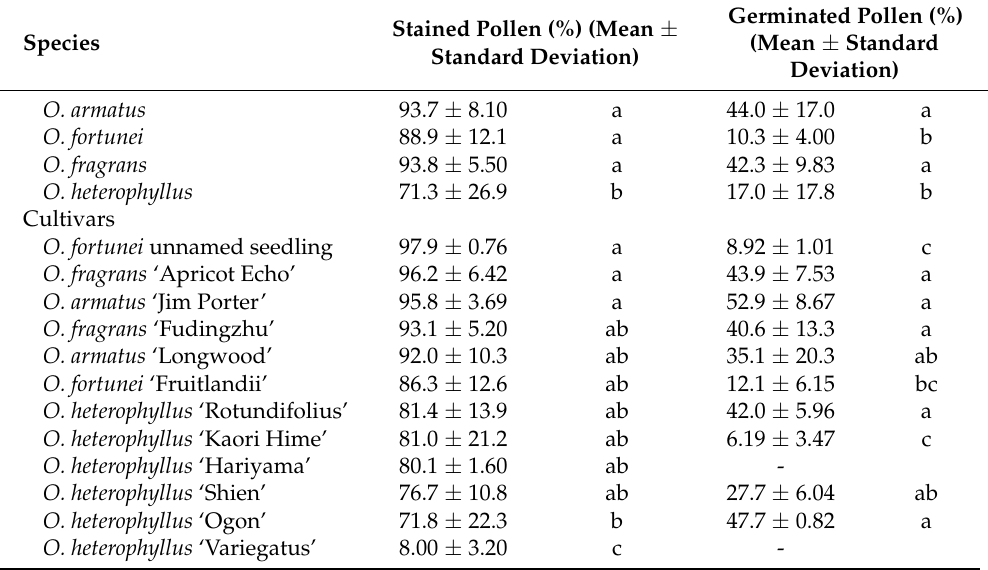
Figure 2. Flower of Osmanthus fragrans ‘Apricot Echo’ ( A —male-only flower, B —perfect flower), ‘Fudingzhu’ male-only flower ( C ), and ‘Tianxiang Tiage’—male-only flower ( D ). Petals were re- moved from B and C to fully expose pistils ( B ) or pistillodes ( A , C , D ). Flowers were photographed between 11 November 2017 and 9 January 2018 in McMinnville, TN, USA under a light microscope at 2 × magnification with an Olympus Q Color 5 digital camera. Table 5. Pollen viability of Osmanthus species and cultivars. Means followed by the same letter were not significantly different at the α = 0.05 significance